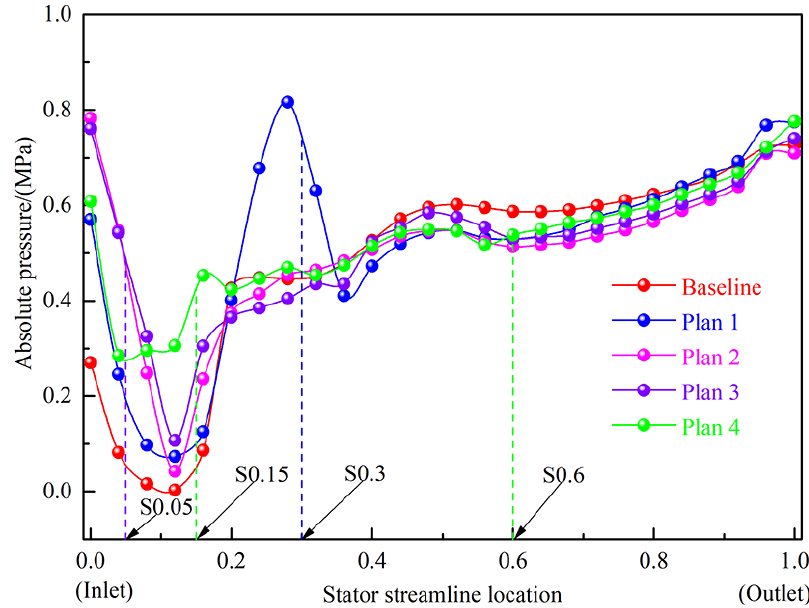
Figure 13. Stator suction surface load distribution with different suppression slots under stall operating condition.